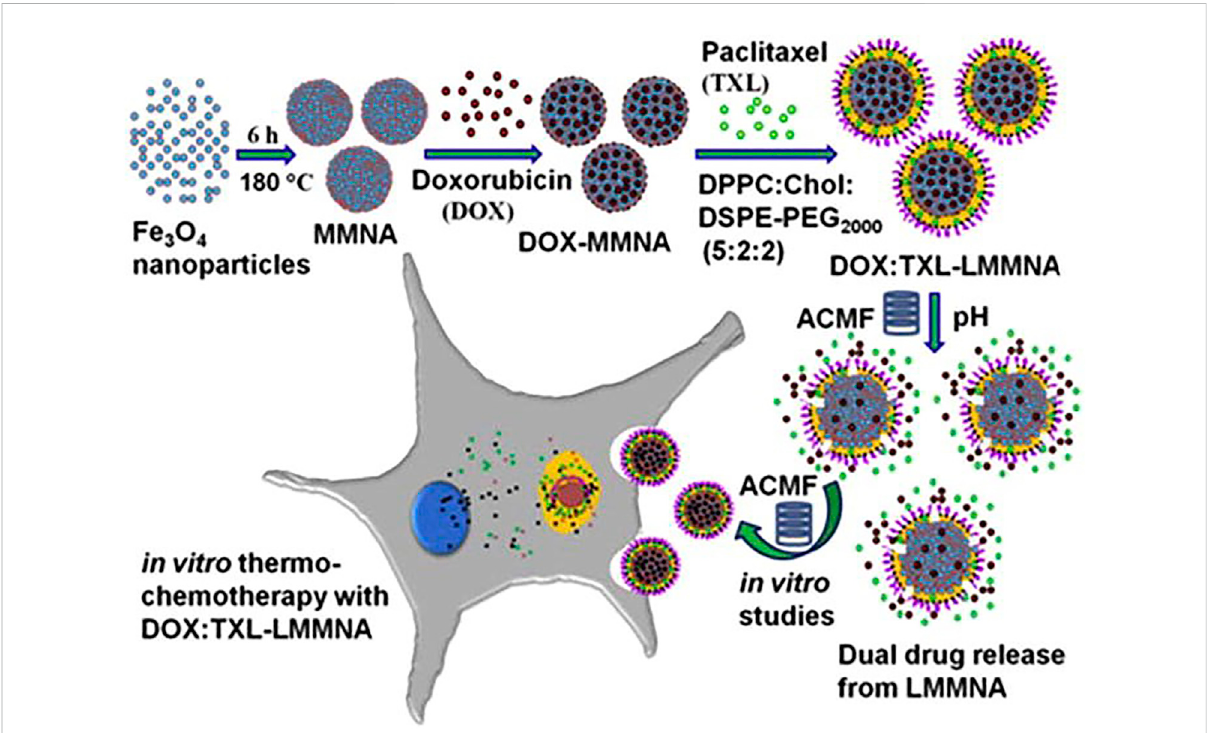
FIGURE 3 The overall concept of the present study: the pH-sensitive and thermosensitive LMMNA is a dual drug delivery system containing the drugs doxorubicin (DOX,in mesopores) and paclitaxel (TXL, in lipid layer). Drugrelease istriggered by an ACMF applied to thetumor cells. In thispaper, the formulation and in vitro characterization of dual drug-loaded LMMNA with an ACMF is reported for the thermos-chemotherapy of cancer. Reproduced from Ref (Pradhan et al., 2014). with